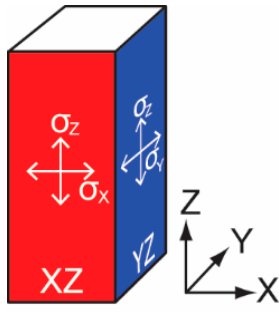
Figure 3. Horizontal and vertical residual stress components, σ X, σ Y , and σ Z shown at the center of the